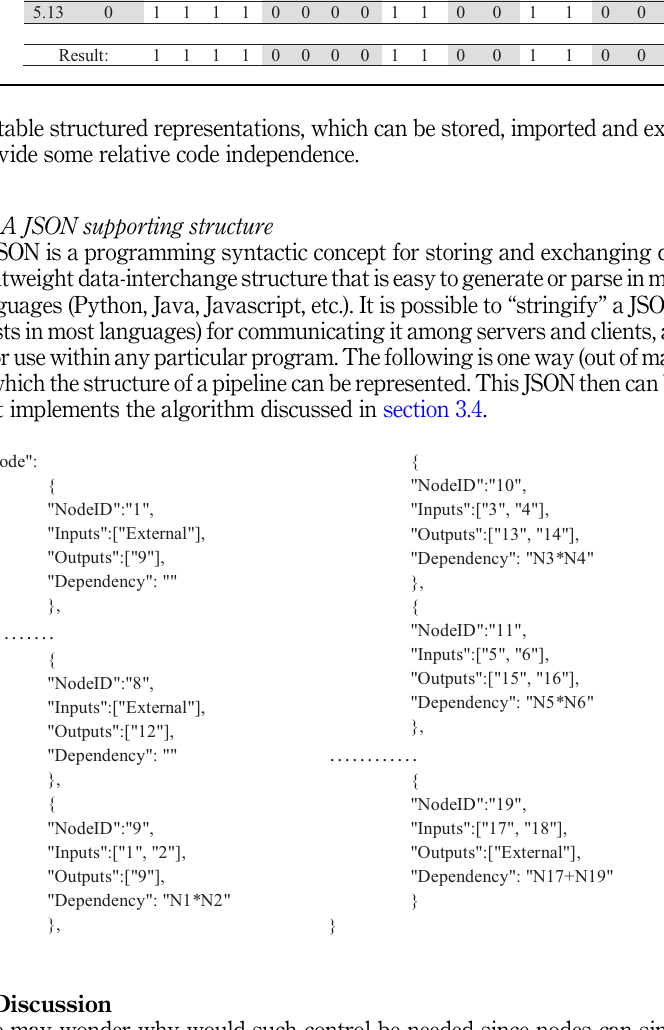
Table 3. Step-by-step